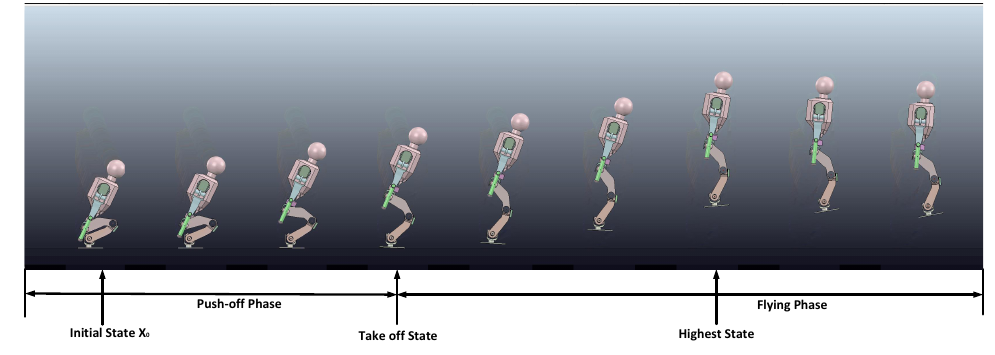
Figure 16. Screenshot of the